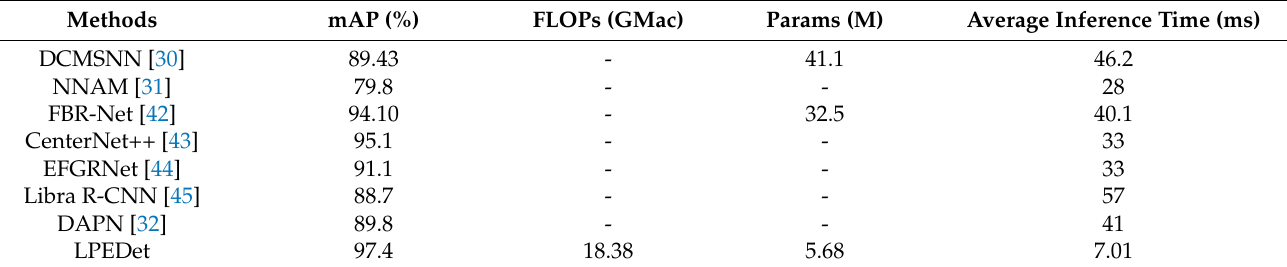
Table 5. Comparison with the latest SAR ship detection